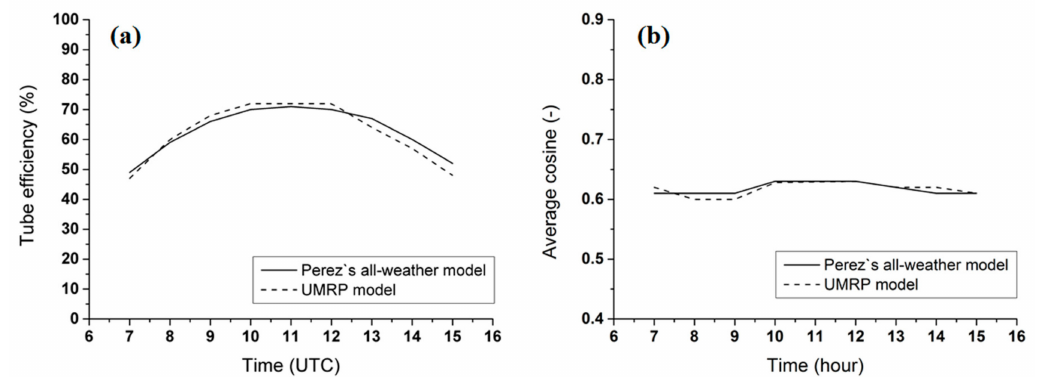
Figure 6. Light tube e ffi ciency ( a ) and average cosine ( b ) computed for H = 1.5 m, r = 0.26 m, ρ = 0.934 using data recorded during clear sky conditions on 16 February 2015 (see Tables 1 and 3). The dashed lines are for the UMRP model, while the solid lines are for Perez’s all-weather model.